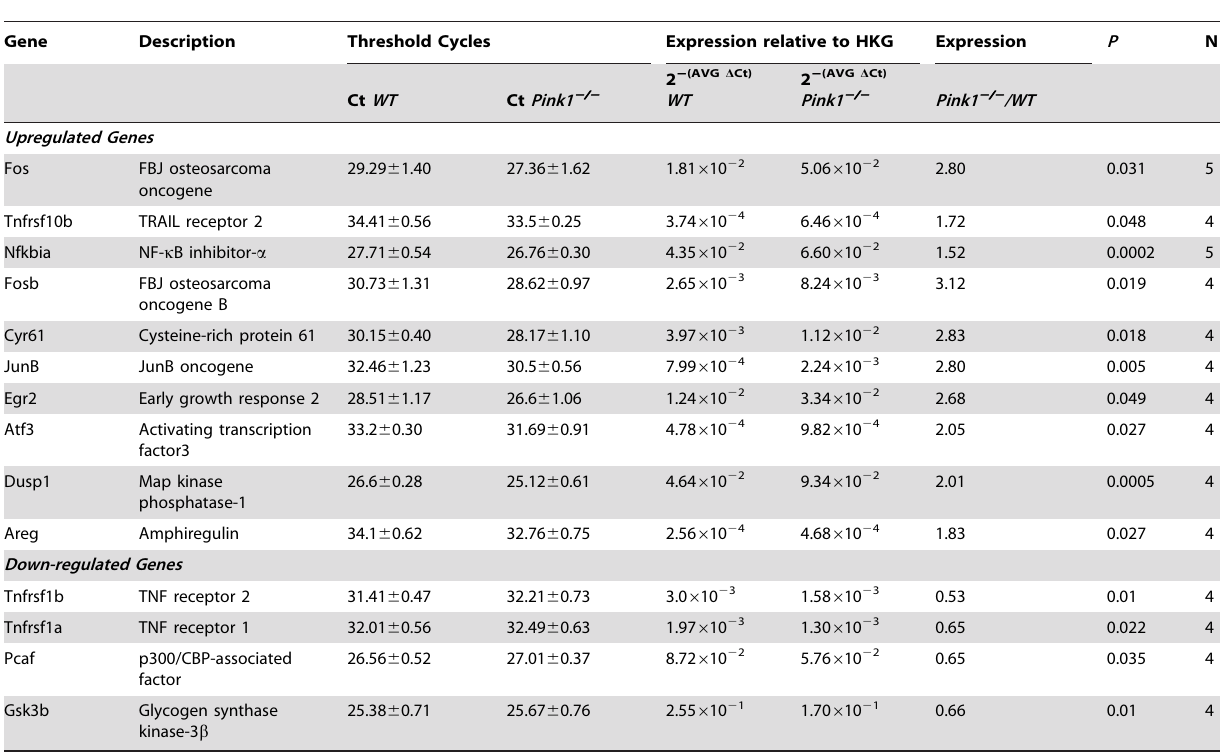
Table 1. Genes with significantly altered expression in the striatum of Pink1 2 / 2 mice.